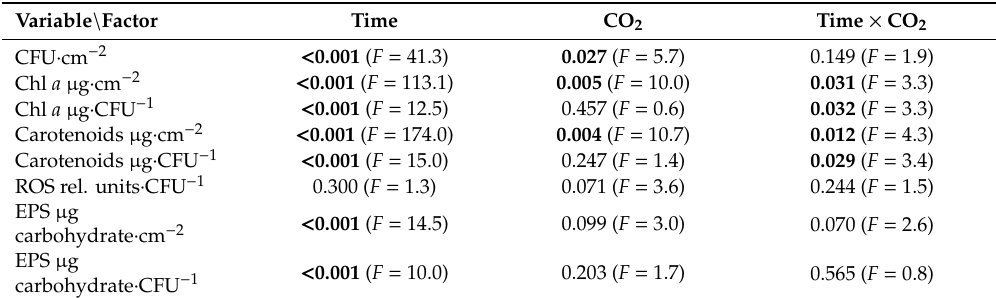
Table 1. ANOVA of the characteristics of the biofilms studied, considering the incubation time and the addition of inorganic carbon in the medium as factors. p -values ≤ 0.05 are indicated in bold type.